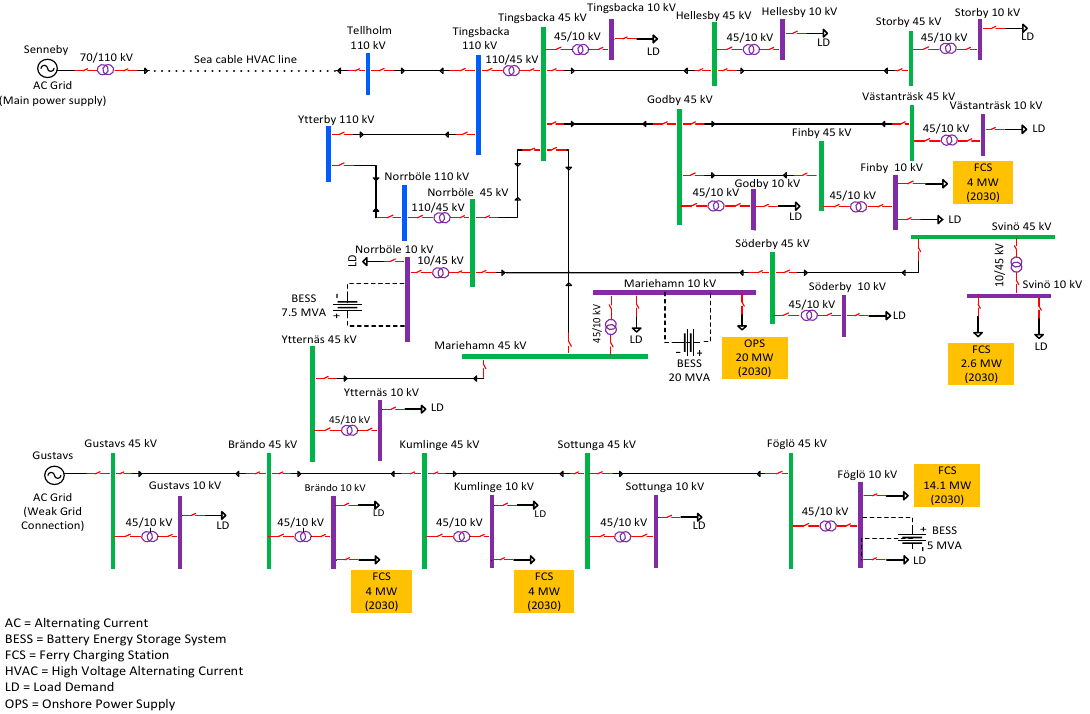
Figure 15. Radial mode operation of the electricity network in the Åland Islands for the year 2030 with BESSs.